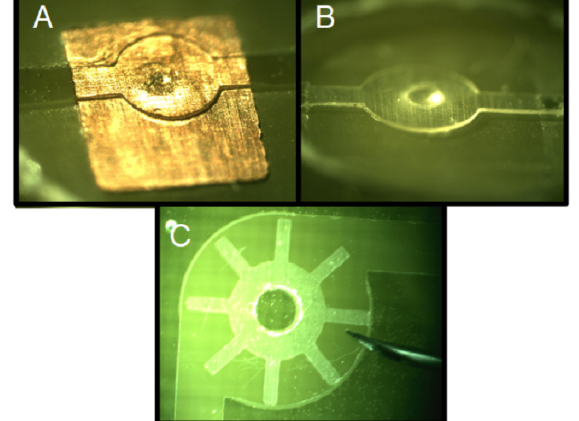
Figure 21. ( A ) Safety valve where the free-standing is not released due to the copper layer (copyright (2010) IEEE. Reprinted, with permission, from [238]). ( B ) Safety valve where the free-standing was released due to the copper layer etching (copyright (2010) IEEE. Reprinted, with permission, from [238]). ( C ) Released wheel for flow measurement made of SU-8 by etching a copper sacrificial layer (copyright (2013) IEEE. Reprinted, with permission, from